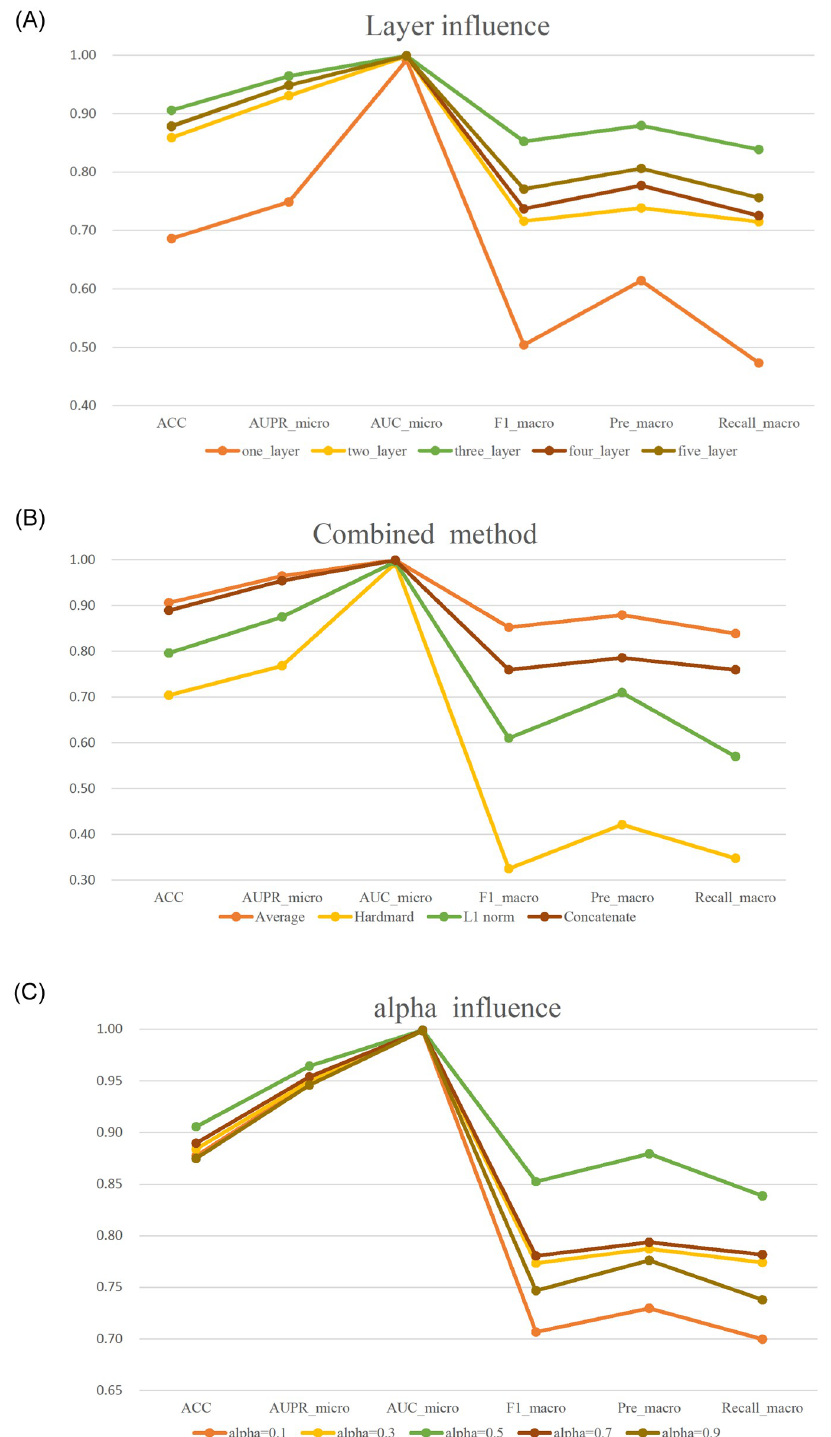
Fig 6. Results of ablation experiments. (A) Effect of the number of GCN layers. (B) Effects of drug combination methods. (C) Effect of the fusion coefficient.